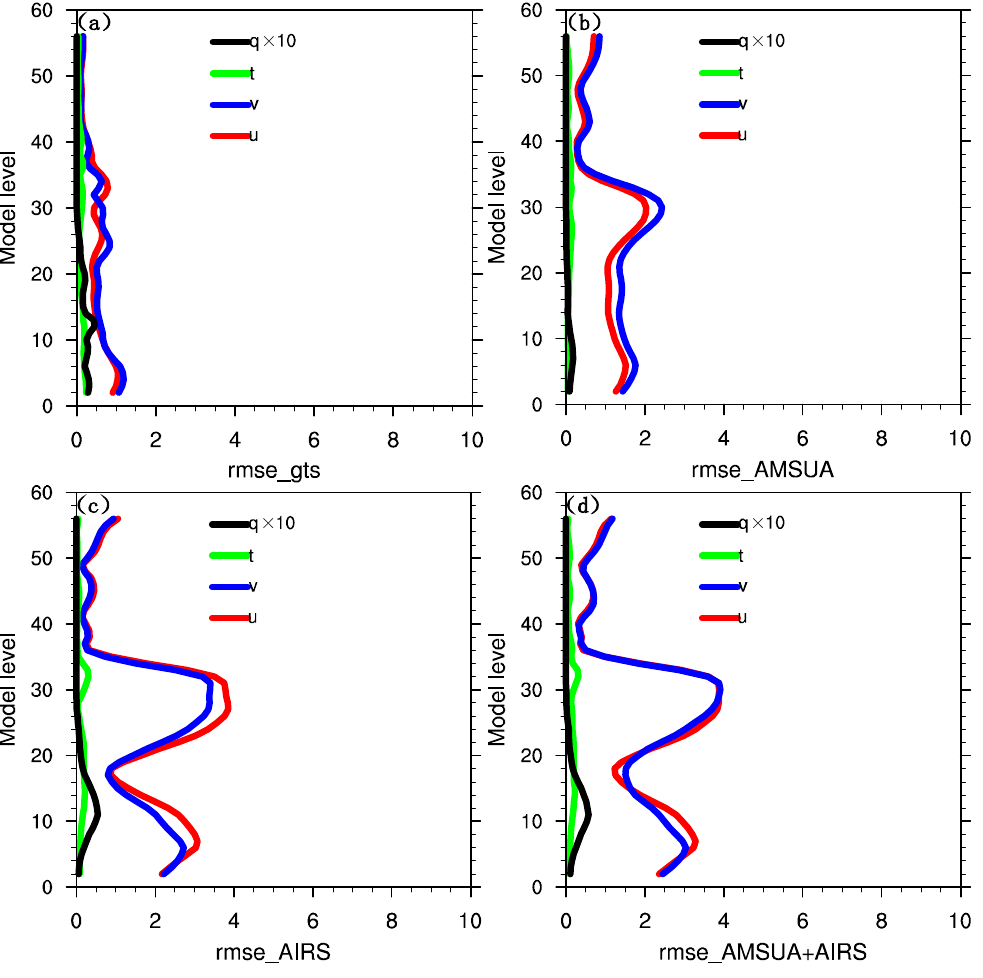
Figure 6. Vertical root mean square error (RMSE) profile for specific humidity (unit: g/kg), temperature (unit: K), zonal wind (unit: m/s), and meridional wind (unit: m/s) of ( a ) Global Telecommunications System data assimilation (GTS_DA), ( b ) AMSU-A_DA, ( c ) AIRS_DA, and ( d ) AMSU-A + AIRS_DA.